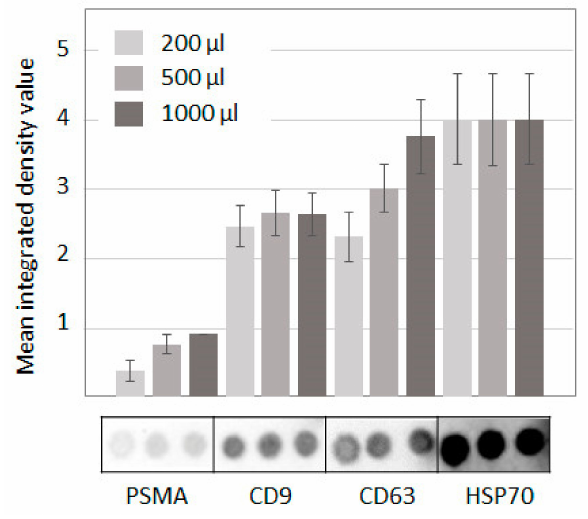
Figure 2. Membrane markers expression in plasma SEVs. Assessment of the relative concentration of membrane markers (PSMA, CD9, CD63, and HSP70) in the total population of plasma SEVs isolated from 200, 500, and 1000 µ L of pellet pure plasma of healthy male donors by dot blotting. The integrated density values were obtained from spots, and the results of 8 participants were averaged.